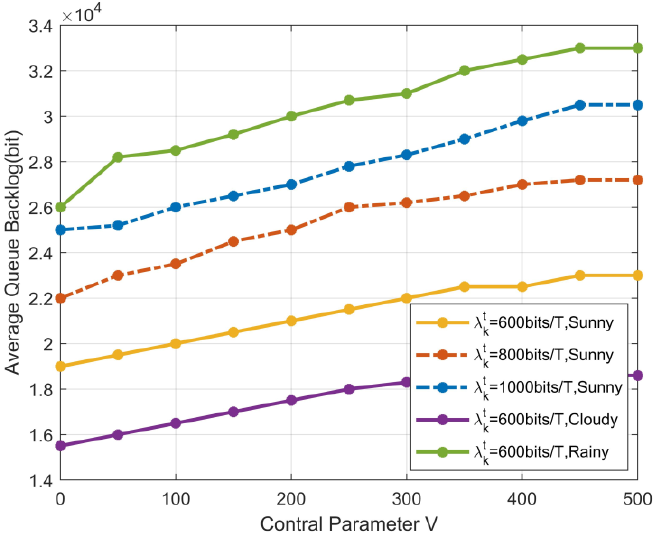
Figure 6. Queue backlog vs. control parameters V.